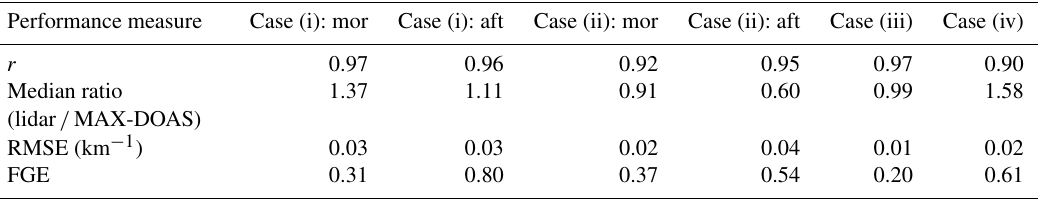
Table 4. Quantitative performance statistics of MAX-DOAS aerosol extinction calculations (BOREAS algorithm) compared to lidar mea- surements.